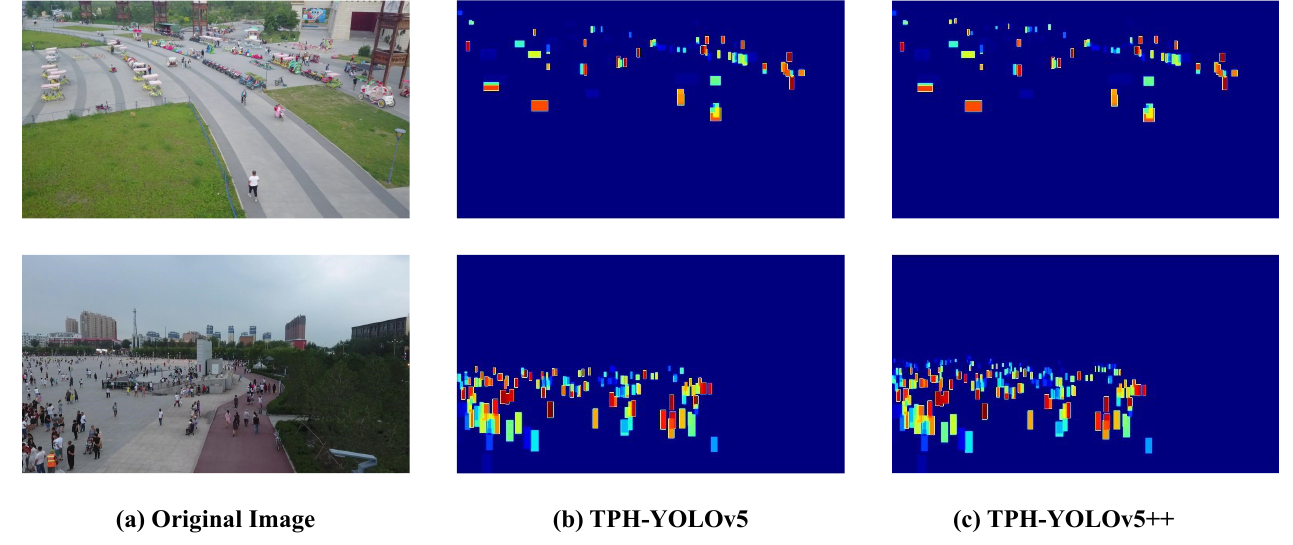
Figure 11. Spatial distributions of correct bounding boxes generated by the small prediction heads of TPH-YOLOv5 and